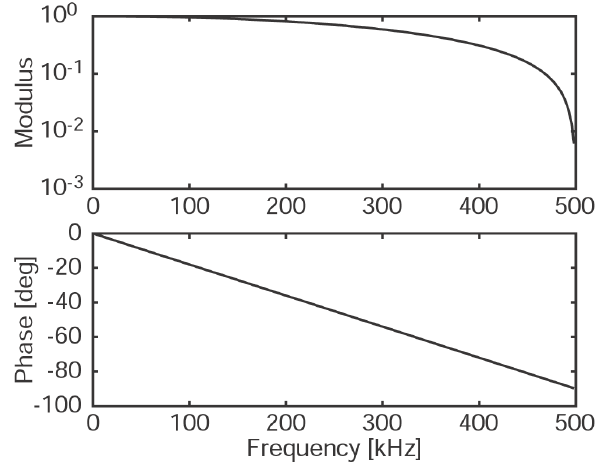
Fig. 1. The upper panel shows the amplitude response of the digital filter and the lower panel portrays its phase